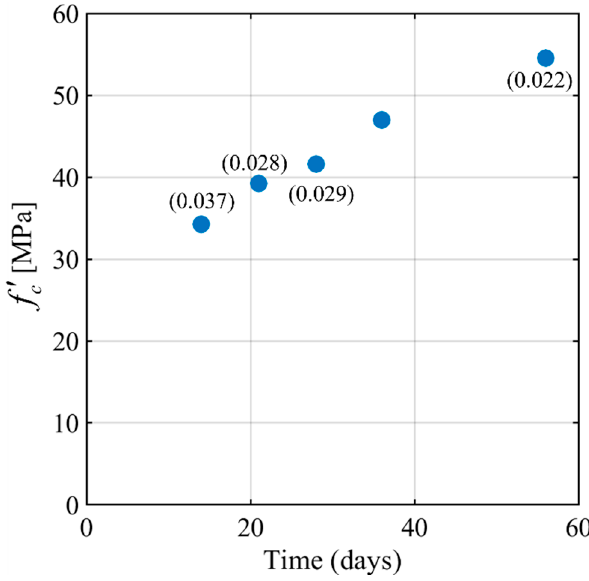
′ f ) versus time. Figure 1. Average concrete cylinder compressive strength ( f (cid:48) ) versus c c